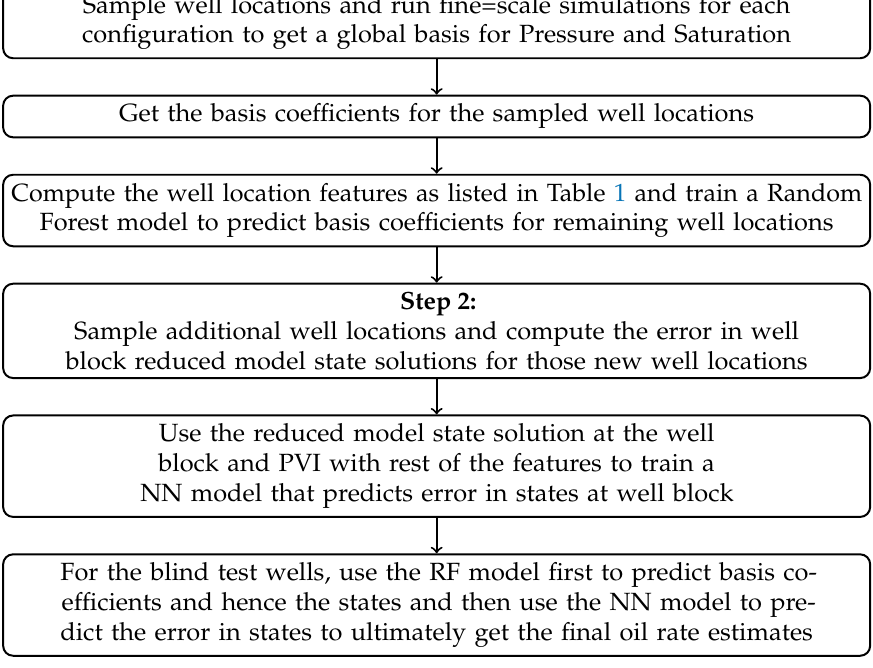
Figure 22. Workflow of the ML-based predict and correct PMOR procedure to estimate well produc- tion rates for new well locations.